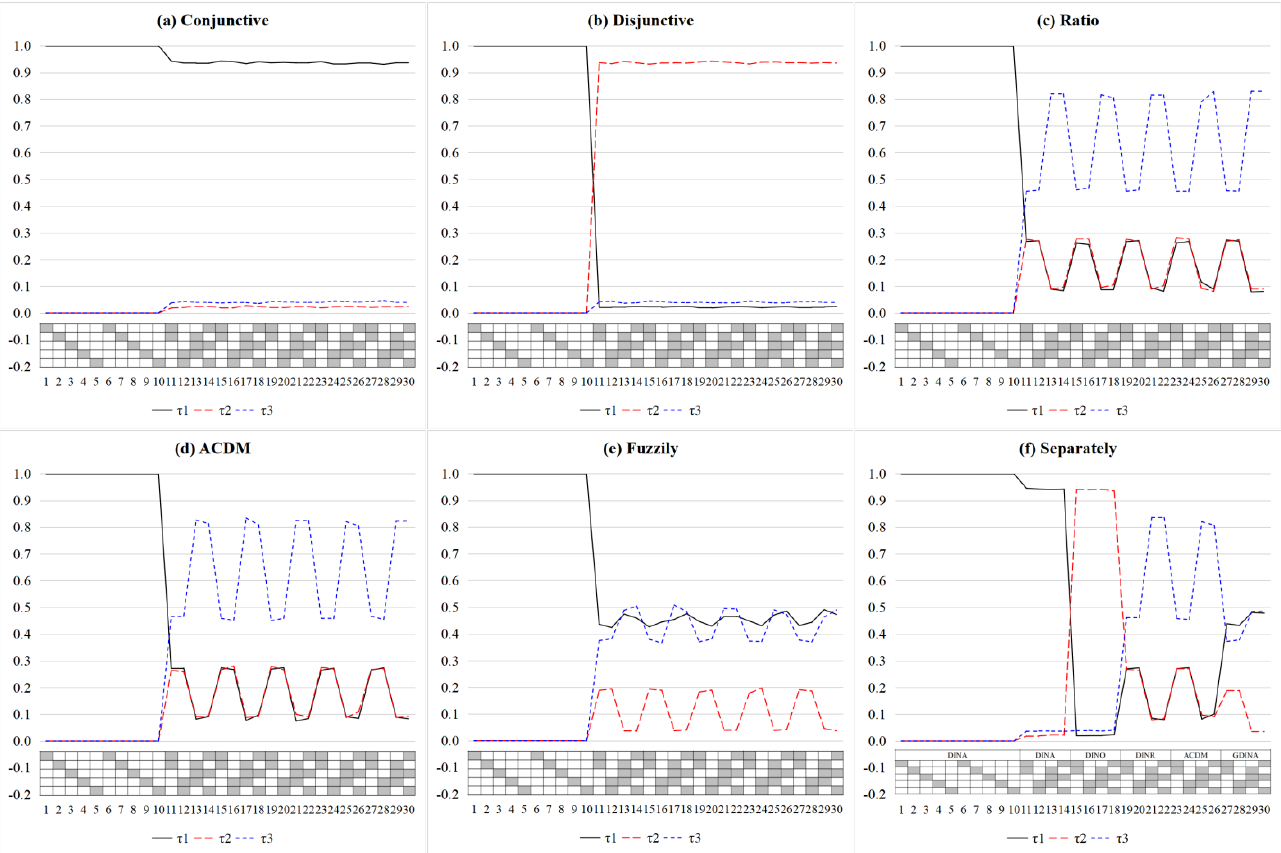
Figure 5. Estimates of the item-level mixing proportion parameter in simulation Study 2 from the DINMix model. Note: The value is the mean value of 30 replications; τ 1 = item-level mixing proportion parameter for the conjunctive condensation rule; τ 2 = item-level mixing proportion parameter for the disjunctive condensation rule; τ 3 = item-level mixing proportion parameter for the ratio condensation rule; DINMix = deterministic input, noisy mixed model; GDINA = generalized DINA model.